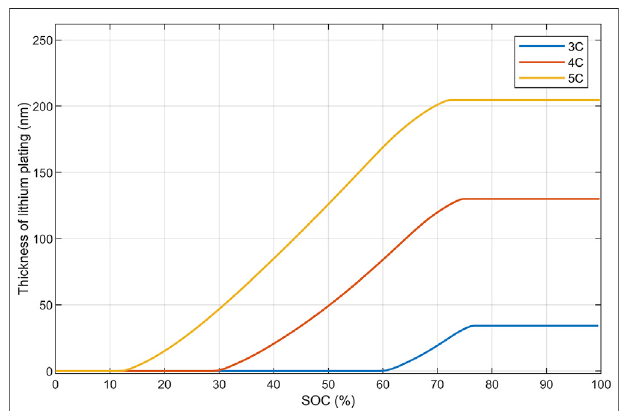
FIGURE 7 | In fl uence of charge rate on lithium plating thickness at different temperatures.